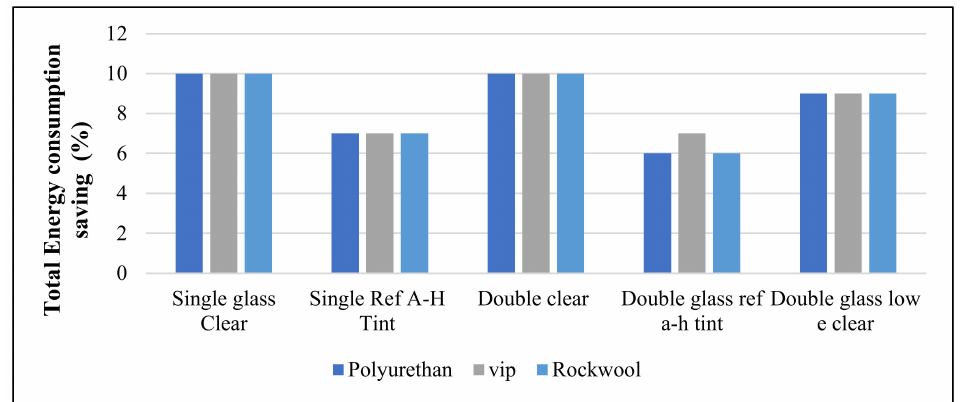
Figure 10. Total energy saving for different types of window glass with the three types of window shutters’ insulations applying the glare with index 18.